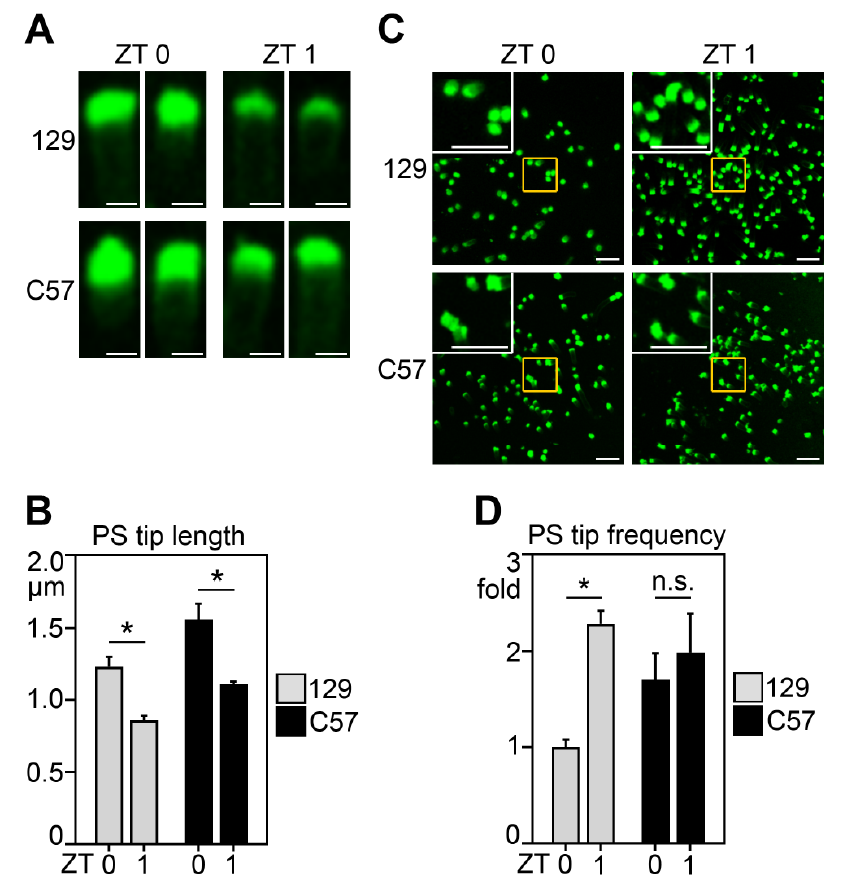
Figure 2. Similar diurnal elongation of PS exposure at rod outer segment tips but reduced PS-POS tip frequency in C57 compared to 129 mice. Whole-mount neural retina mounted outer segment side up was incubated with biosensor labeling externalized PS and live-imaged. ( A ) Images are representative maximal projections showing individual rod outer segments live-imaged at high magnification. Scale bars, 2 μ m. ( B ) Quantification of the length of PS-exposing tips of outer segments from images as in ( A ). ( C ) Representative retina overview fields of PS biosensor live imaging experiments. Images are maximal projections. Inset with white borders in top left corner of each field shows magnification of areas indicated by yellow rectangles. All scale bars in ( C ), 10 μ m. ( D ) Quantification of the frequency of outer segments exposing PS in C57 and 129 mice of samples as in ( B ). Values are normalized to the frequency of outer segments exposing PS in 129 mice at ZT0. Bars in ( B , D ) show mean ± s. e. m., n = 4–5 for ( B ), and n = 4 for ( D ); two-way ANOVA with Tukey’s post hoc test showed significant differences as indicated by lines (* indicates p < 0.05).